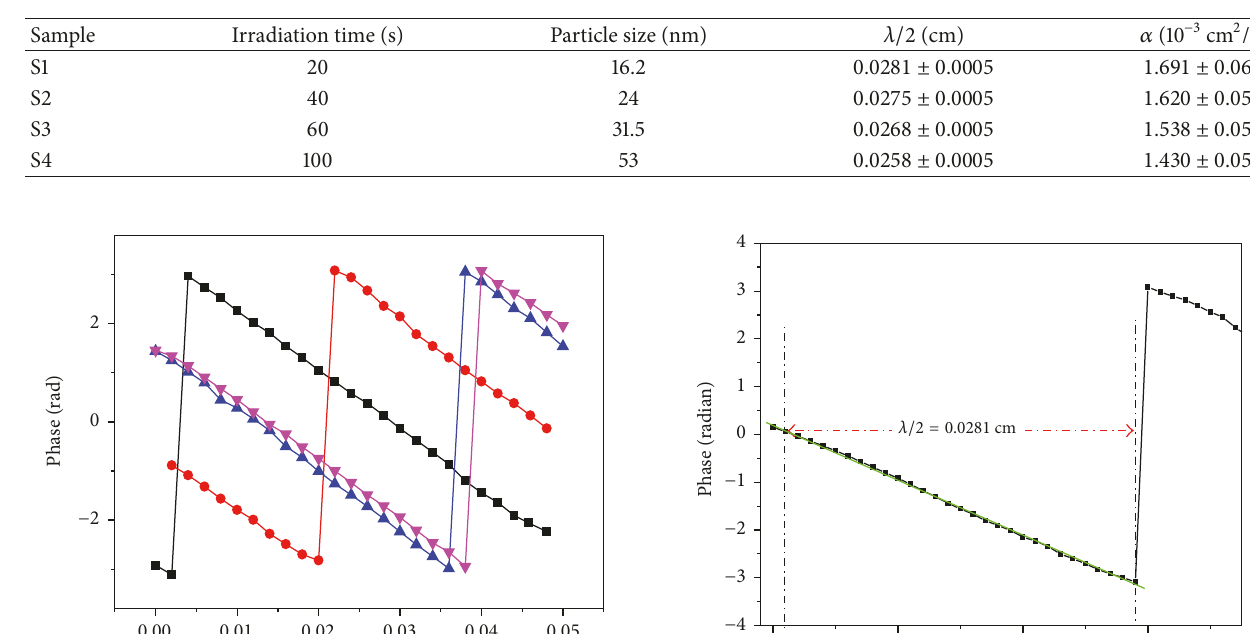
Table 1: Summarized results for thermal diffusivity of Ag nanofluids with varying MI time at different particle sizes.